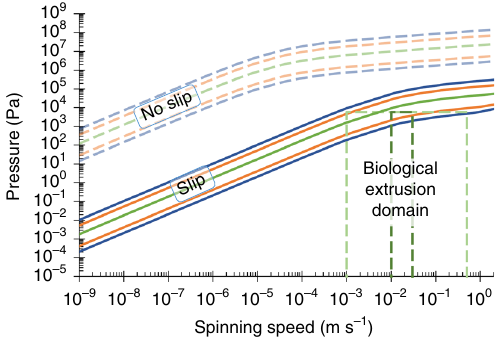
Fig. 7 The effect of wall boundary conditions on pressure requirements. The assumption of a slip condition at the duct wall (with the same geometric and rheological data as used in Fig. 6) brings the lower portion of Laity ’ s ranges ( green : mean-1722 Pa s 57, 58 , orange : 400-5000 Pa s 57 , blue : 200- 10,000 Pa s 58 ) into the biological extrusion domain. The biological extrusion domain is split into natural ( dark green dashes ) and forced ( pale green dashes )